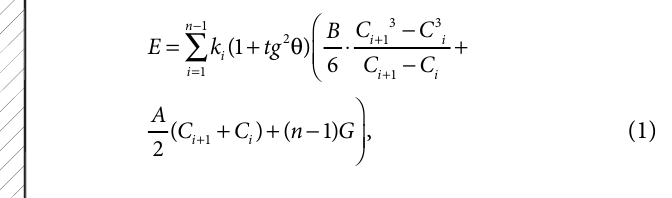
Fig. 3. Direct collision with a wall